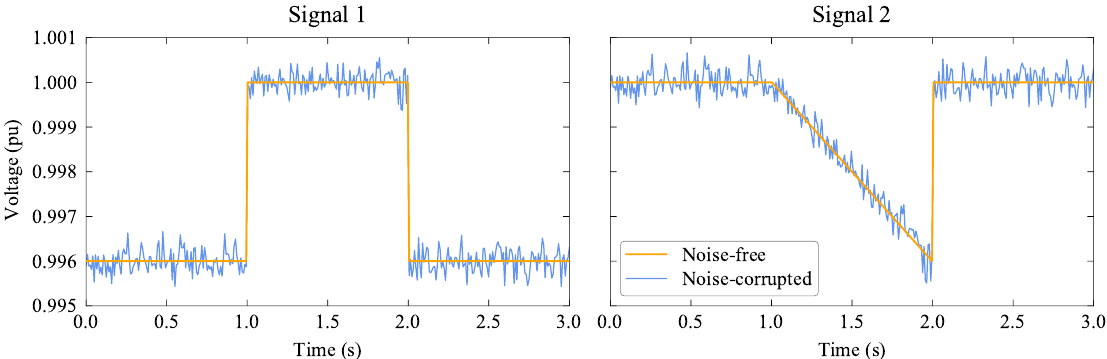
Figure 4. Synthetic signals analyzed throughout this study (both before and after noise